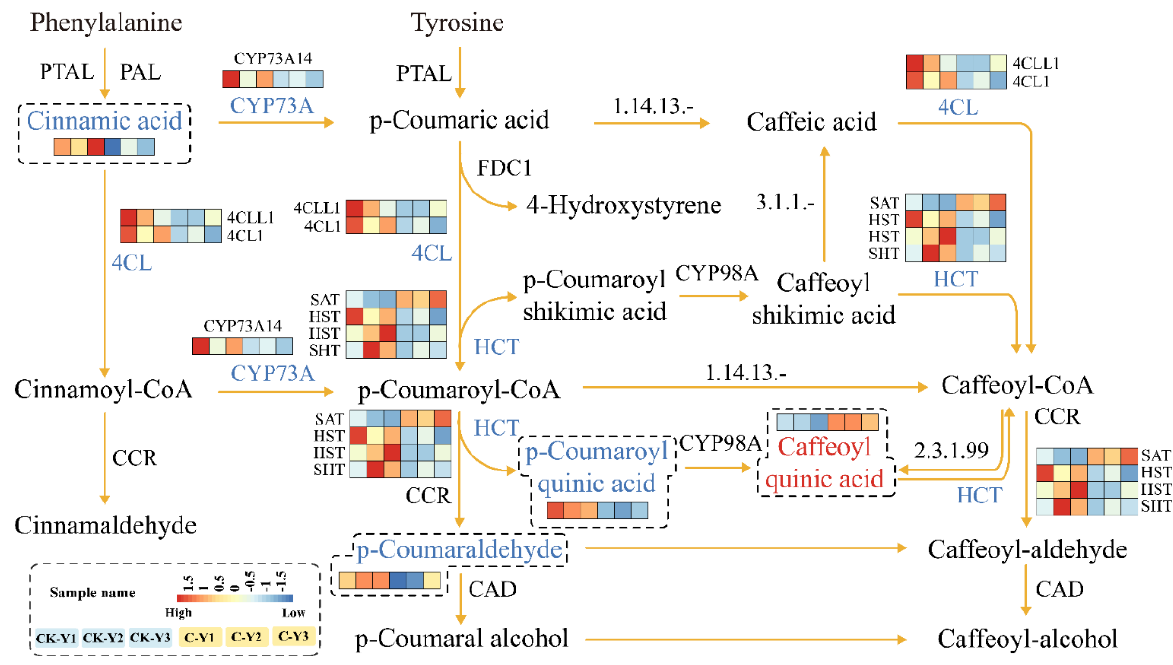
Figure 11. A Schematic Diagram Developed from the Integration of Differentially Expressed Genes (DEGs) and Differentially Accumulated Metabolites (DAMs) in the Phenylpropanoid Pathway in Stems. Three biological control leaf samples (CK-Y1, CK-Y2, and CK-Y3) and three biological treated leaf samples (C-Y1, C-Y2, and C-Y3) are coded by three squares or rectangles in the order of CK-Y1, CK-Y2, CK-Y3, C-Y1, C-Y2, and C-Y3. The six squares or rectangles were used to create heatmaps. The expression levels of genes and accumulation levels of metabolites in C-Y1, C-Y2, C-Y3, C-Y1, C-Y2, and C-Y3 are coded by colored heatmaps of the six squares or rectangles. 4CL, CYP73A, and HCT coded with a light blue color on each arrow mean that their gene expression levels are downregulated in the treated stems. Cinnamic acid, p-coumaraldehyde, and p-coumaroyl quinic acid, which are coded with a light blue color and included together in a heatmap contained in a dashed box, mean that their levels are decreased in the treated stems, while caffeoyl quinic acid coded by a red color means its